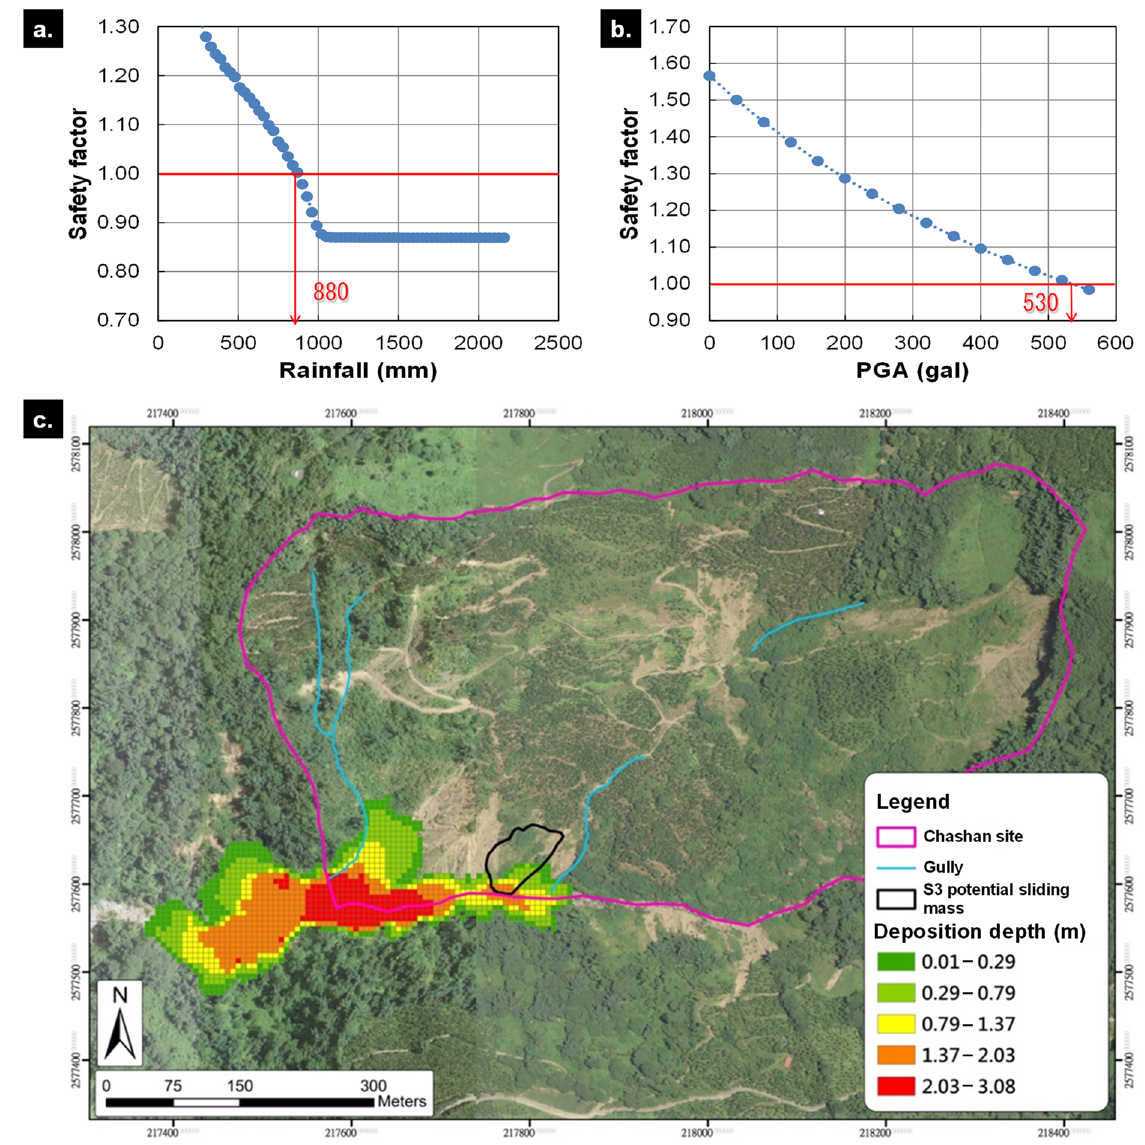
Figure 4. Threshold of failure and RAMMS simulation. Thresholds of ( a ) rainfall and ( b ) PGA for triggering landslides and ( c ) the influence zone and accumulation depth for the failure scenario of the B3 potential sliding mass.